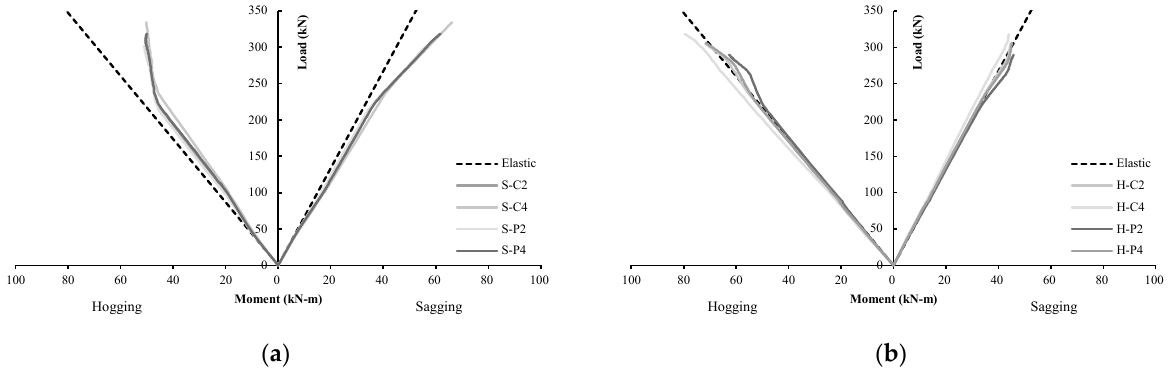
Figure 19. Numerical load–moment relationships: ( a ) Group A (sagging strengthening); ( b ) Group B (hogging